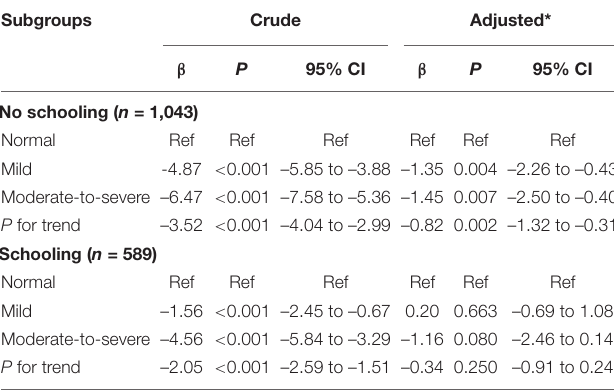
TABLE 4 | The association of malnutrition with cognitive function stratified by age. Subgroups